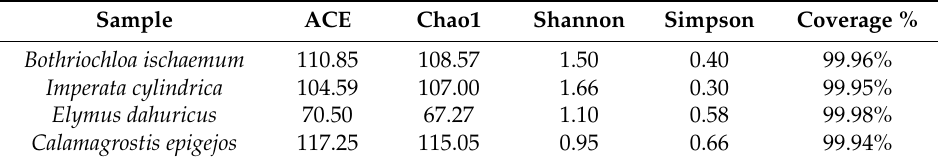
Table 1. Diversity and richness indices of native grass.